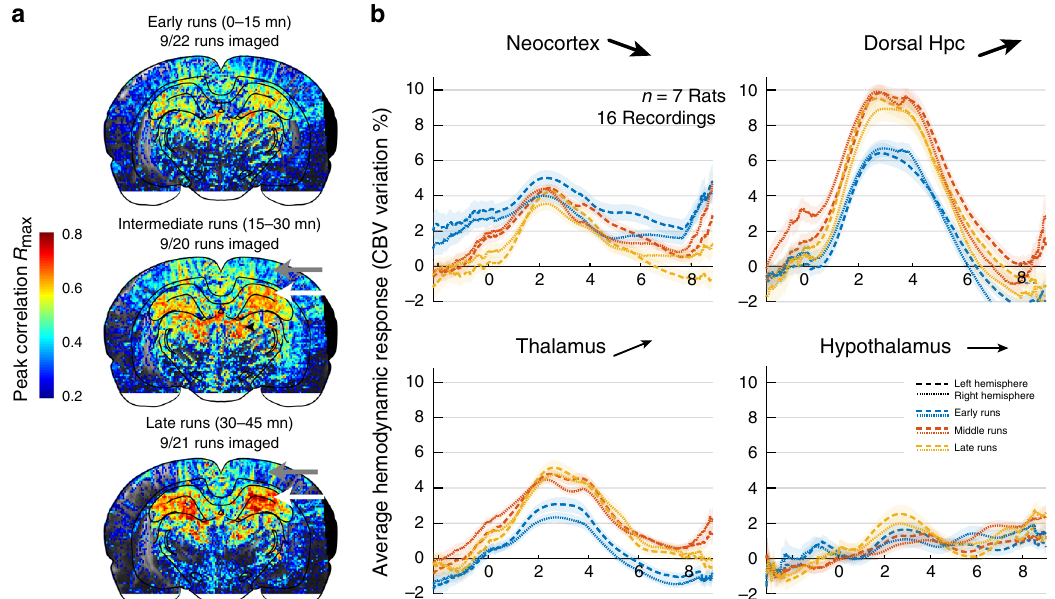
Fig. 5 Strong region-dependent modulation of hemodynamics across trials within the same recording session. a Maximal correlation maps relative to animal speed, as shown in Fig. 3b for three groups of trials, namely early (0 – 15 min from recording onset), intermediate (15 – 30 min), and late (>30 min) runs. Note the gradual involvement and the strong potentiation in the dorsal hippocampus (white arrows) and the inverse pattern in the cortex (gray arrows). b Average hemodynamic responses in four major brain regions grouped by early (0 – 15 min), intermediate (15 – 30 min), and late (>30 min) groups. These hemodynamic responses were computed for all coronal recordings that contained at least 24 imaged runs in total (AP = − 4.0 mm, n = 7 animals, 16 out of 25 recordings). Neocortex and hippocampus/thalamus regions display opposing modulation patterns, showing that this phenomenon is not a global effect of temperature or reward during the task. Arrows indicate the tendency of the region to either potentiate, remain stable, or depress during the session. Error bands correspond to the mean values ±sem. Source data are provided as a Source Data fi